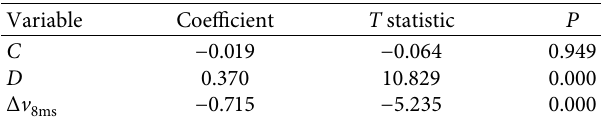
Table 14: Significance of coefficients (mean velocity variation in a certain window width).